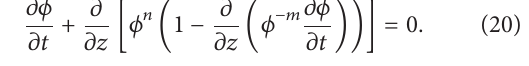
Figure 1: The (𝑚, 𝑛) -plane. The conservation laws are constrained to the region 𝑚 ≥ 0 , 𝑛 ≥ 0 . The special cases are the straight lines 𝑛 + 𝑚 − 1 = 0 , 𝑛 + 𝑚 − 2 = 0 , 𝑚 = 1 , and 𝑛 = 𝑚 − 1